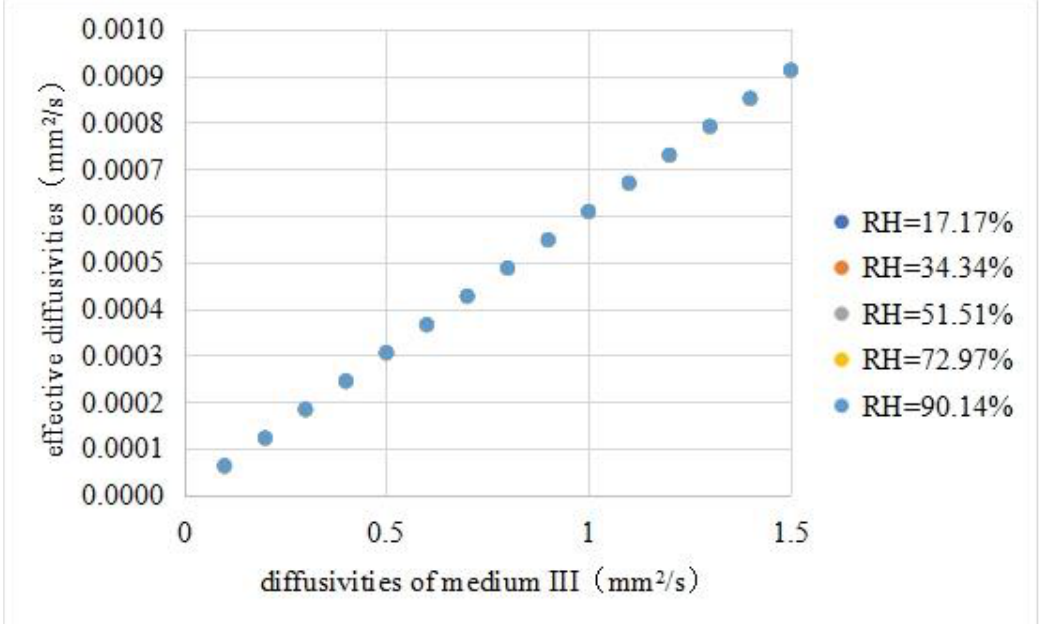
Figure 11. Effective diffusivities vs. diffusivities of medium III.